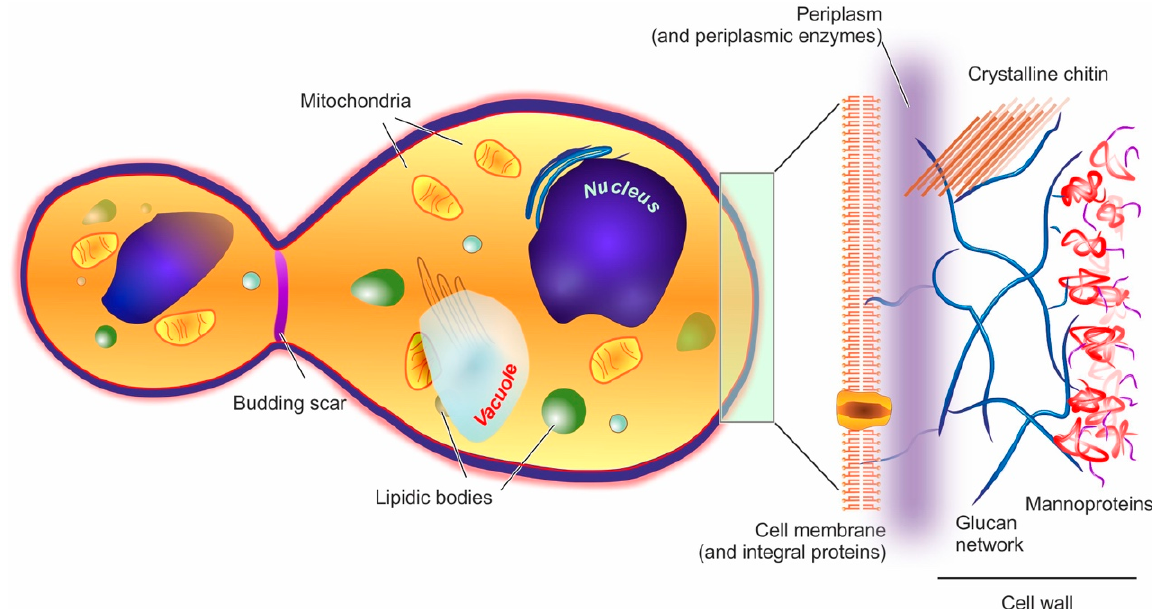
Figure 1. In the structure of a yeast cell (here represented in a post-budding state), the elements potentially acting as barriers to encapsulation (cell wall and cell membrane) are depicted in a magnified fashion on the right hand side of the figure.